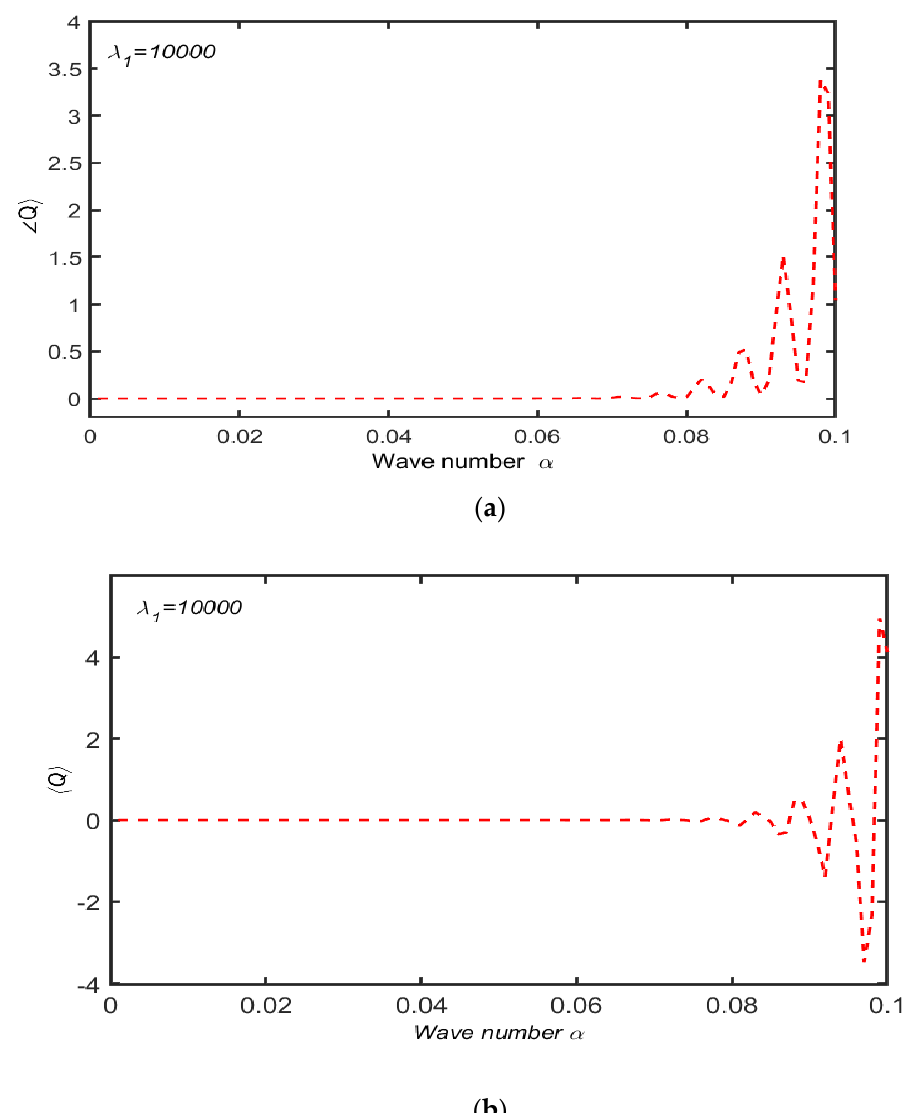
Figure 9. ( a ) Dimension-less net flow rate (cid:104) Q (cid:105) for linear model with λ 1 = 10000 when other parame- ters are R = 10 4 , χ = 0.6. ( b ) Dimensionless net flow rate (cid:104) Q (cid:105) for convected model with λ 1 = 10000 when other parameters are 𝑅 = 10 (cid:2872) , 𝜒 = 0.6.